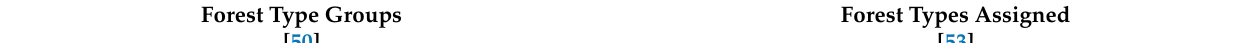
Table A3. Assignment to forest type groups. Assignment of forest types [53] to forest type groups